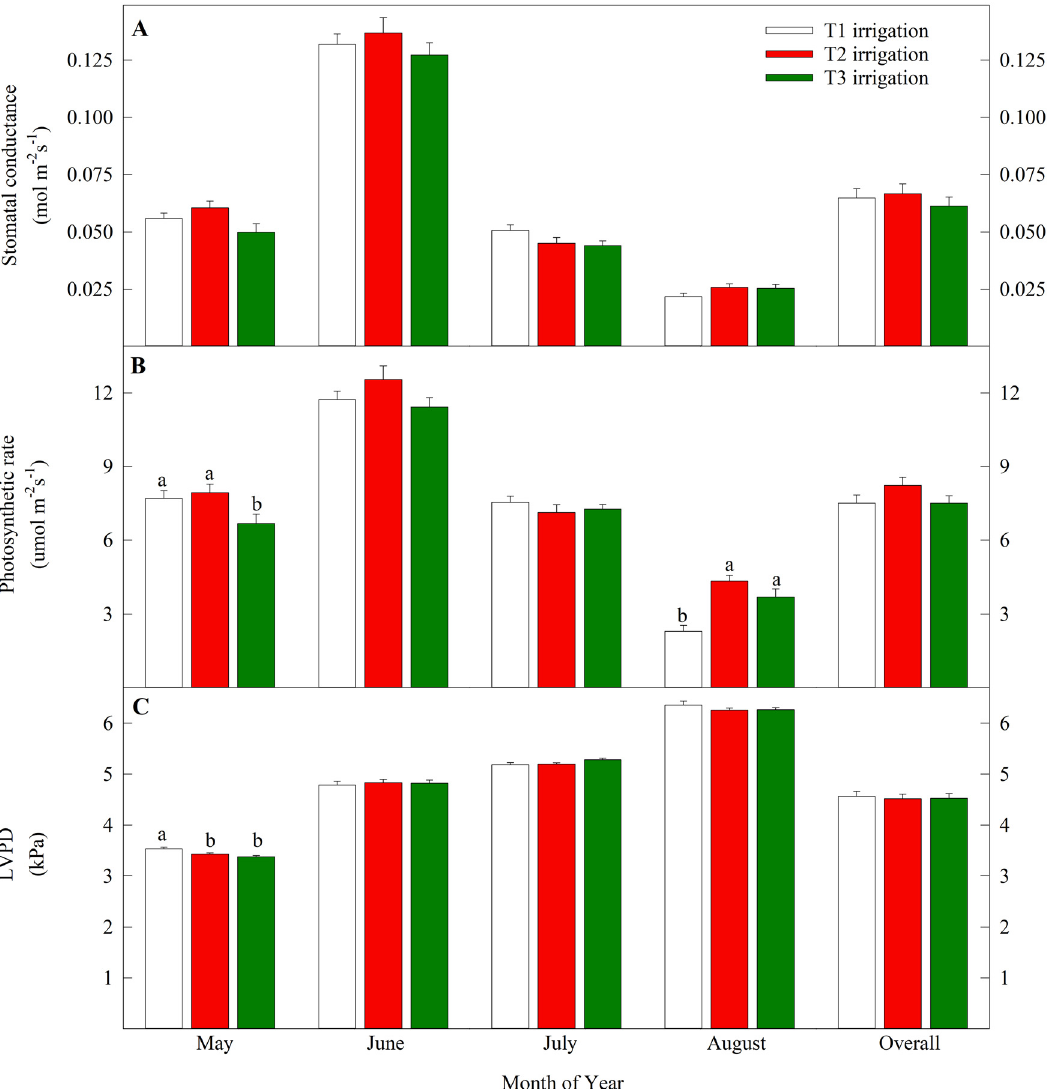
Figure 3: E ff ect of three irrigation regimes on leaf stomatal conductance ( a ) , photosynthetic rate ( b ) , and LVPD ( c ) for olive trees ( Olea europaea L. cv. “ Arbequina ” ) growing in Orchard 3 ( located near Artesia Wells, TX ) . Letters above each bar represent di ff erences between T1 ( single irrigation emitter ) , T2 ( two irrigation emitters ) , and T3 ( control, three irrigation emitters ) irrigation treatments ( Tukey – Kramer test, P ≤ 0.05 ) . Error bars represent SE for each irrigation